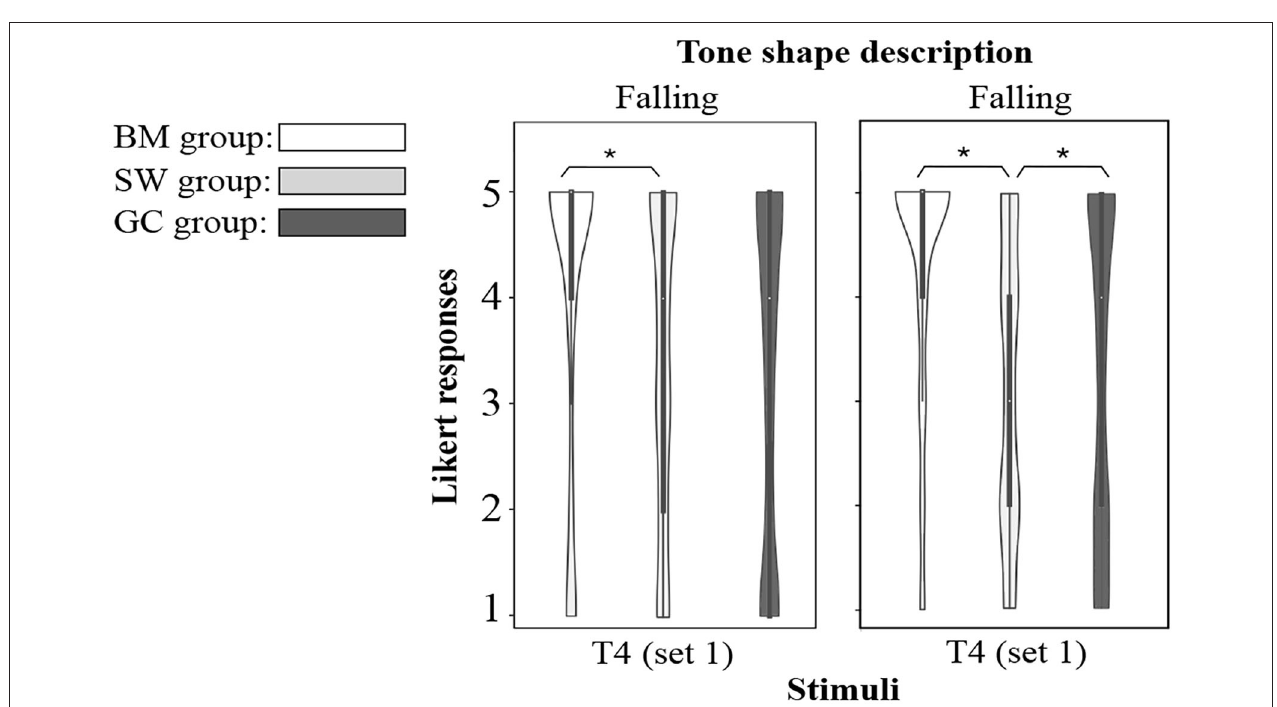
FIGURE 4 | Distribution of tone shape description responses for stimuli with significant between-group difference. Responses were separated by dialect group and tone set.